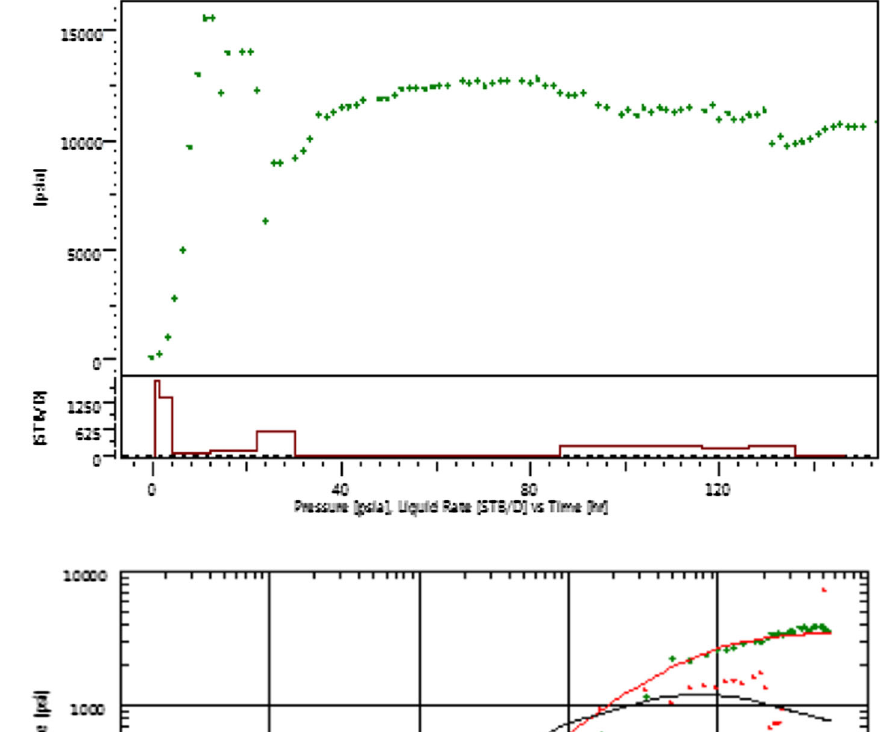
Fig. 3 Simulated derivative- type curve for circle scenario